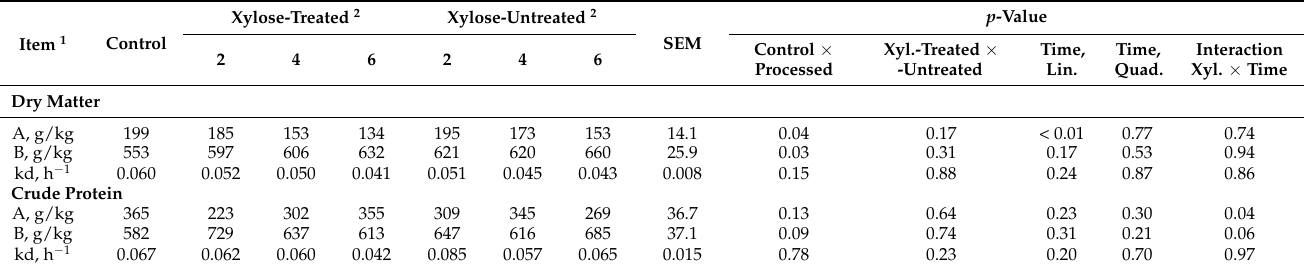
Table 6. Effects of microwave-oven heating and xylose inclusion on rumen degradation parameters of cottonseed